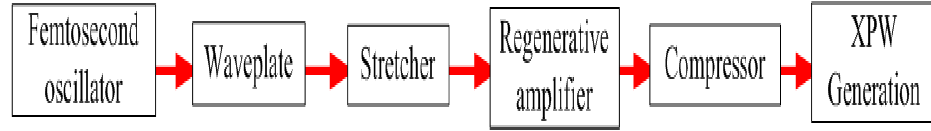
Figure 4. The outline of the experimental setup of gain compensating and XPW generation.